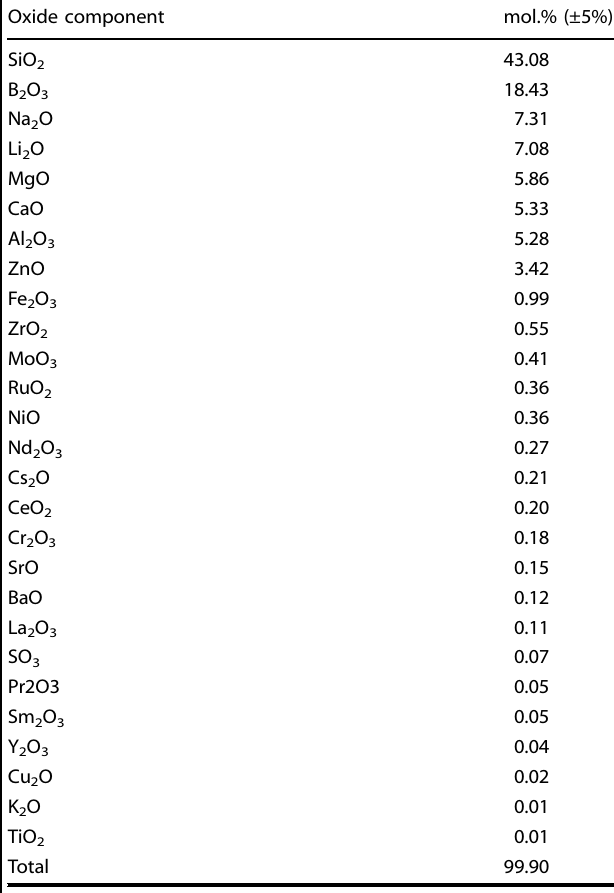
The error on all values is derived from the instrument analytical error, and is ±5%.